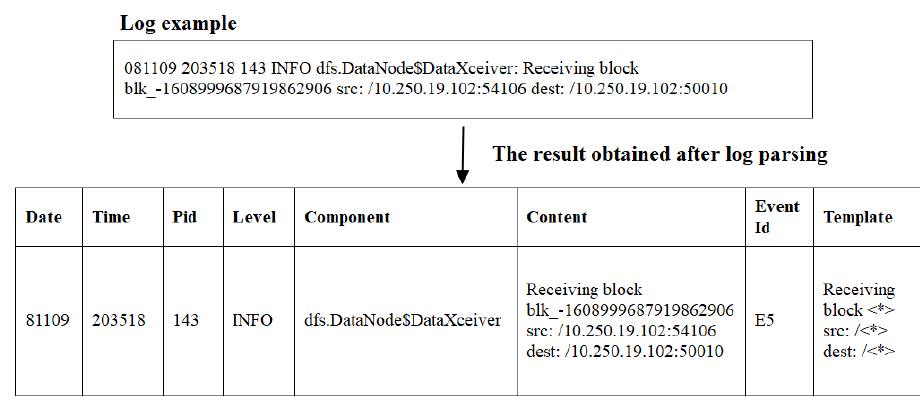
Figure 1. Example of log